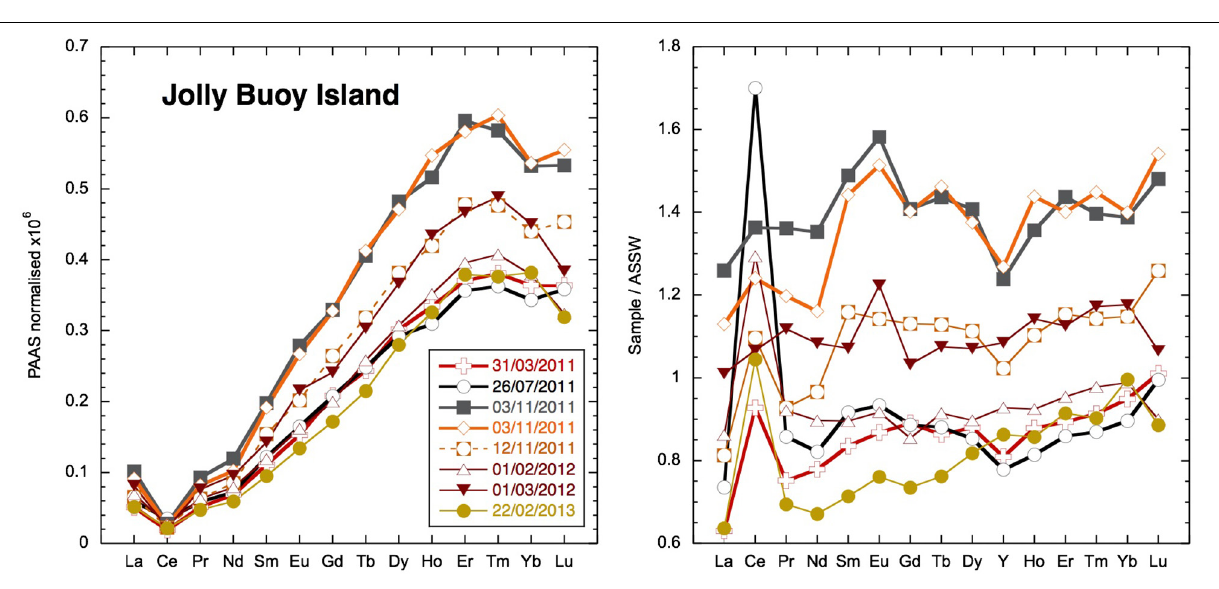
FIGURE 7 | Jolly Buoy Island YREE time series shale (PAAS; Nance and Taylor, 1976) and Andaman Sea Surface water (ASSW) normalized (PA10 < 0.04- µ m dissolved phase from Nozaki and Alibo,